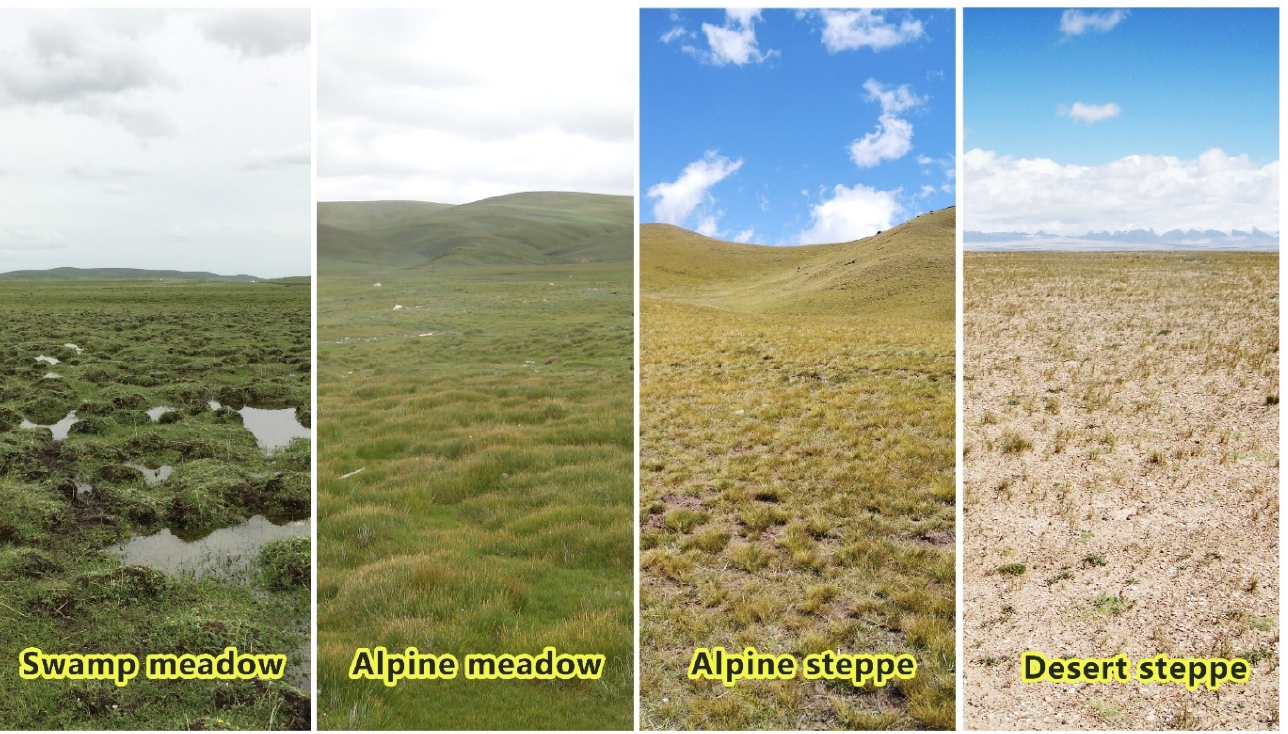
Figure 2. Four typical alpine grassland photos from Sanjiangyuan National Park. (The photos were taken by Yanqiang Wei).